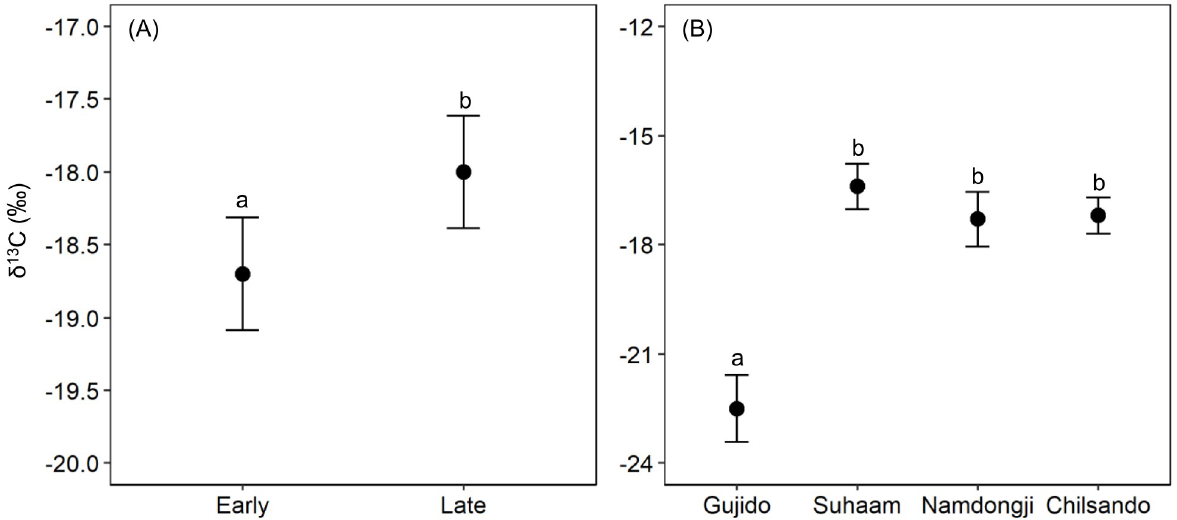
Fig 3. Least square means and standard error of the δ 13 C values of primary feathers of Black-faced Spoonbill chicks according to (A) chick- rearing period and (B) breeding colony. Means with the same letter are not significantly different (Tukey’s post hoc tests).